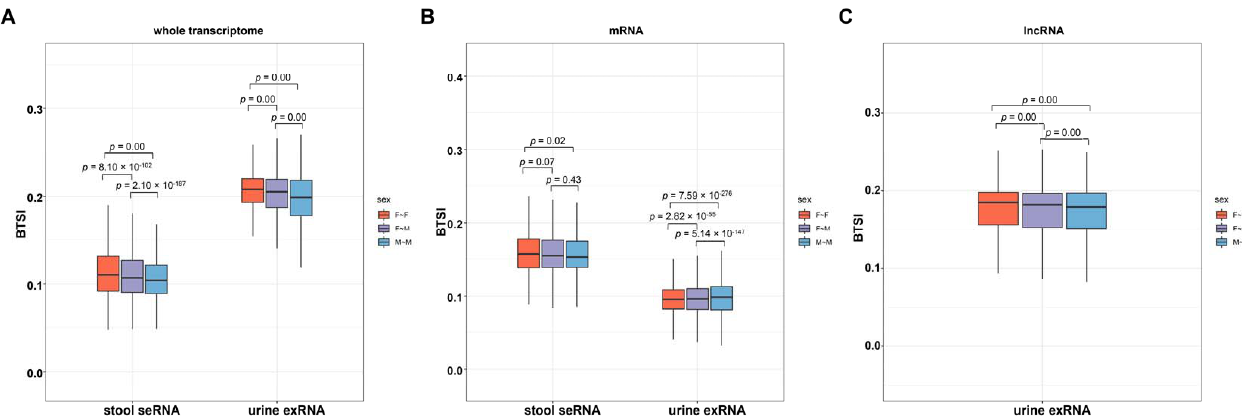
Figure 4. Potential influencing factor of biofluid–tissue correlation. Boxplot depicting the comparison results of the BTSI levels between biofluids and tissues taken from female donors and male donors from the whole transcriptome ( A ), mRNA ( B ) and lncRNA ( C ); the middle line of each box represents the corresponding median BTSI value. The colors of each boxplot indicate biological sexes of biofluid and tissue donors, including both female (F~F), both male (M~M) and different sexes (female biofluid~male tissue or male biofluid~female tissue, F~M). Relevant comparisons were performed with t -test, and the resulting p -values are provided at the top of each